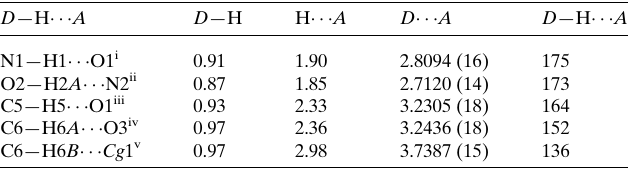
Table 1 Hydrogen-bond geometry (A˚ , (cid:3) ).